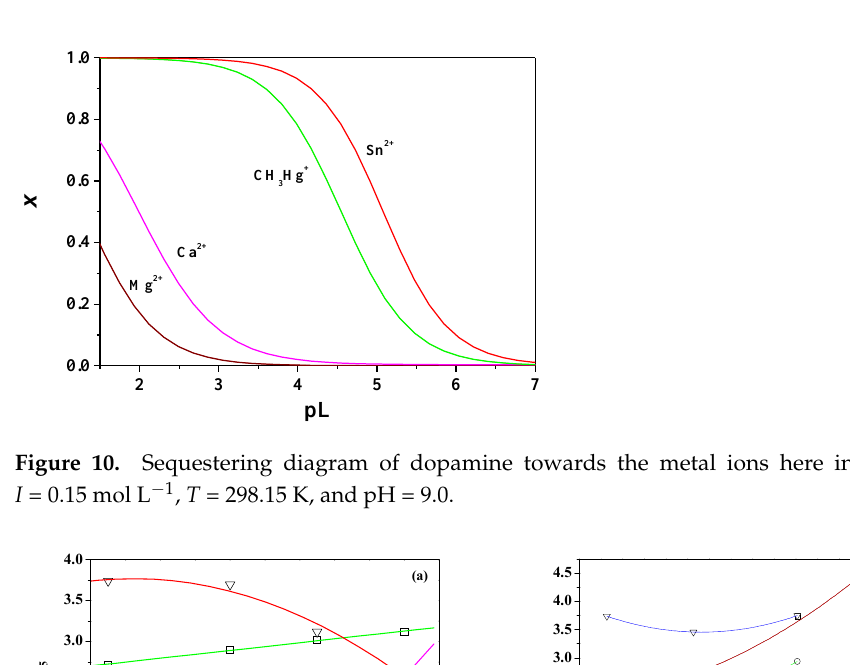
Figure 9. Sequestering diagram of dopamine towards Sn 2+ . ( a ) T = 298.15 K, I = 0.15 mol dm −3 and different pHs. ( b ) T = 298.15 K, pH = 7.4 and different ionic strengths. pL 0 . 5 values: ( a ) 1.30 (pH = 5.0) < 2.33 (pH = 6.0) < 3.74 (pH = 7.4) < 4.31 (pH = 8.0) < 5.07 (pH = 9.0). ( b ) 3.74 ( I = 0.15 mol dm −3 ) < 3.70 ( I = 0.50 mol dm −3 ) < 3.12 ( I = 0.75 mol dm −3 ) < 2.60 ( I = 1.0 mol dm −3 ).